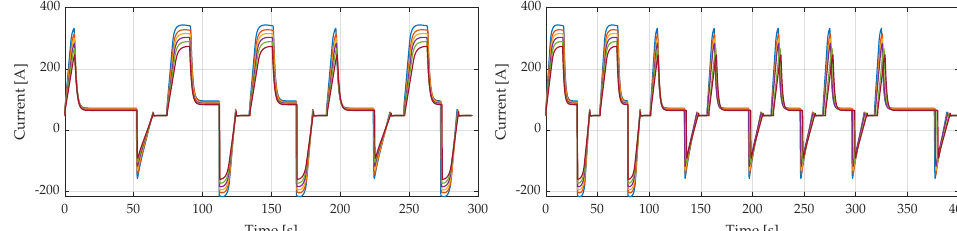
Figure 17. Current of conventional trolleybuses according to the vehicle’s weight covering the outgoing ( left ) and return ( right ) journeys of line 15. The weights start at 30 t (upper blue line) and decrease to 20 t (bottom red line) with 2 t